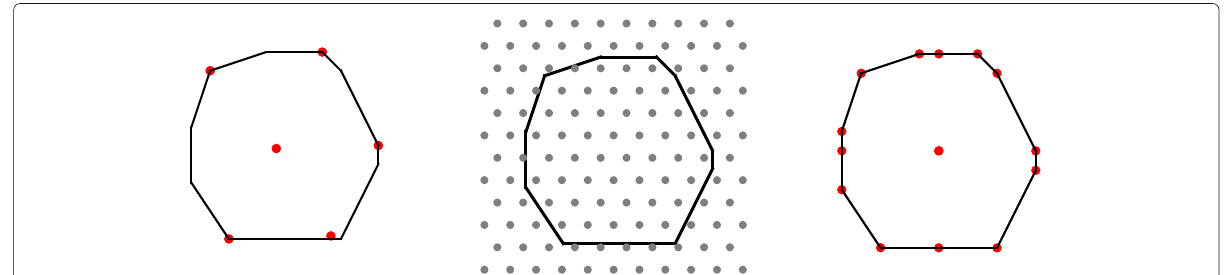
Fig. 3 Initial pivot point strategies for the 4-center problem covering a polygonal area. Left: Solution to the 5-dispersion problem. Middle: Isometric grid. Right: Corner points of the polygon and intersection points extracted from the Voronoi